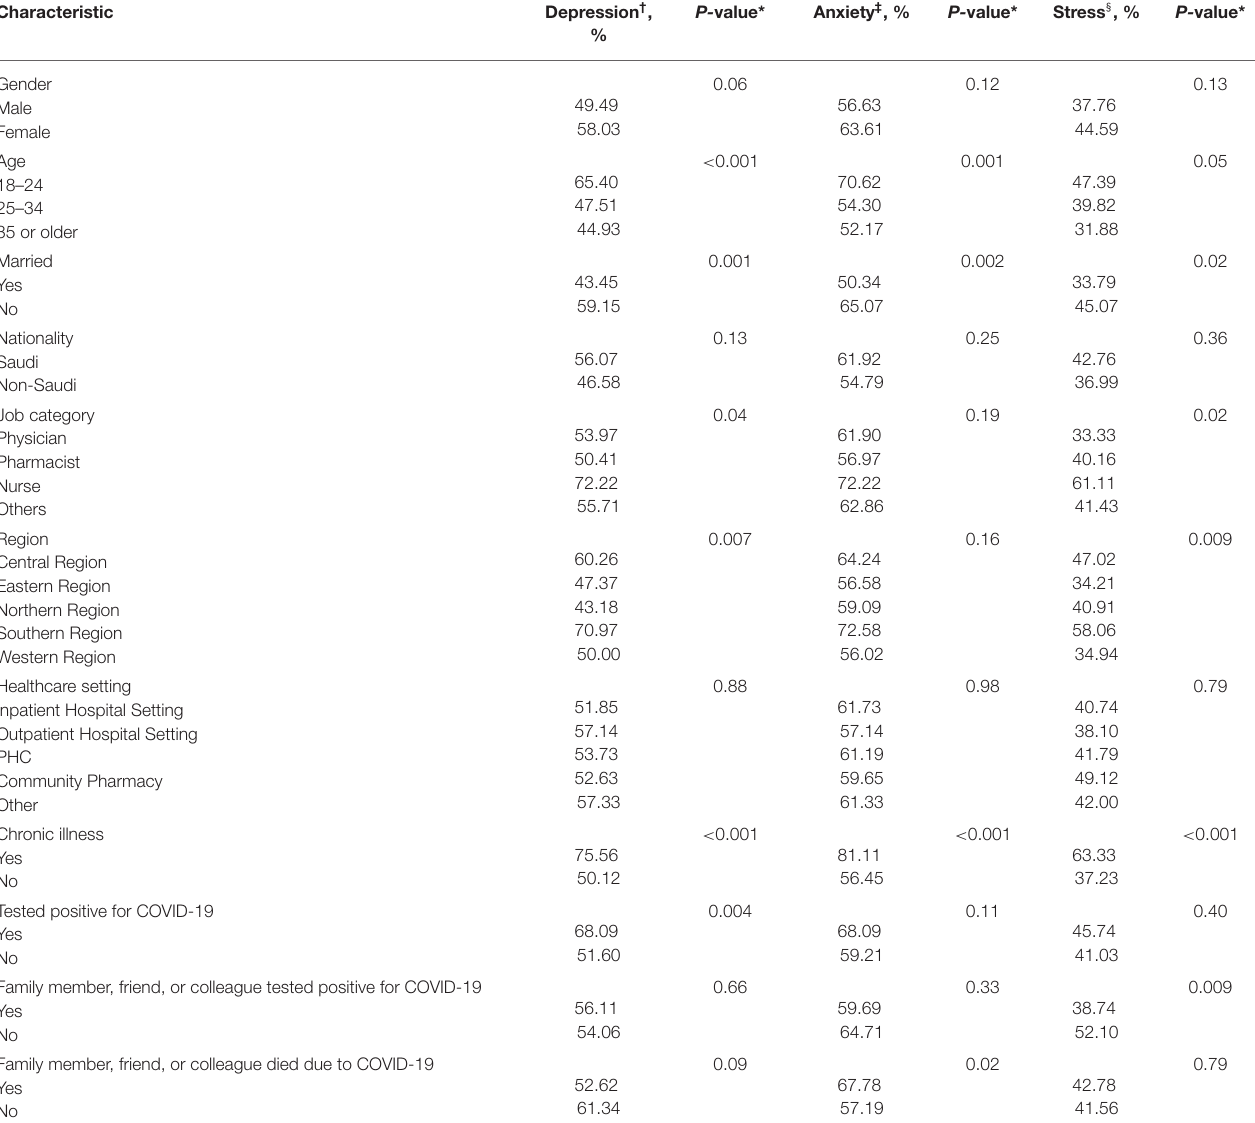
TABLE 2 | Bivariable analysis of depression, anxiety, and stress. Characteristic Depression † , Anxiety ‡ ,